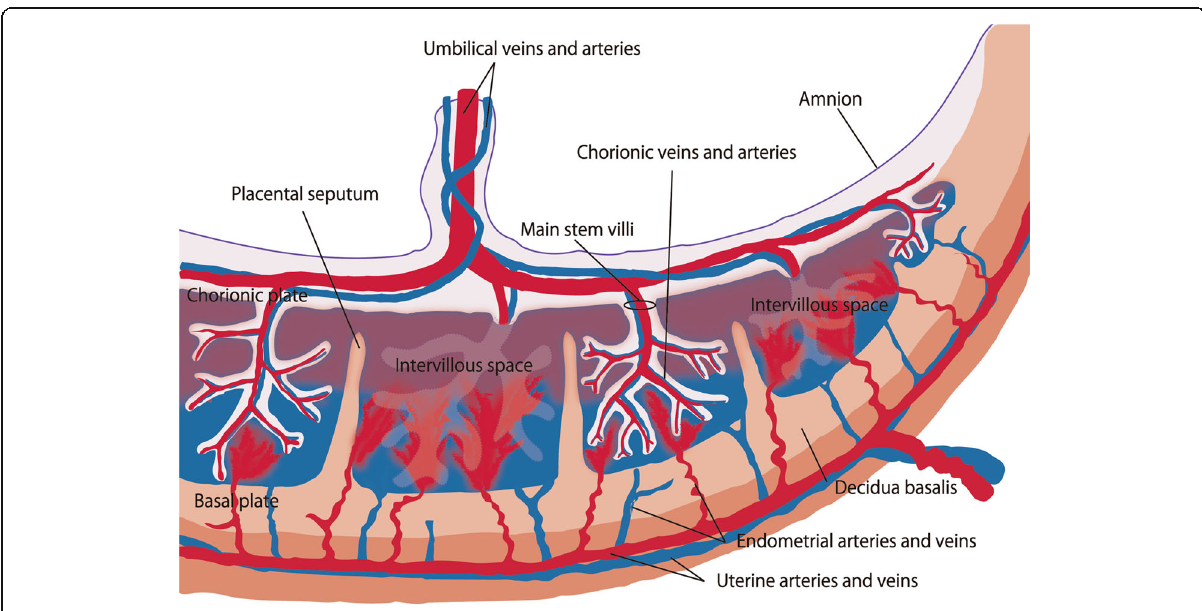
Fig. 3 Schematic drawing of the placenta (cross-sectional image). The chorionic plate (fetal side) is a mass of connective tissue that contains the amnion, main stem villi, and chorionic arteries and veins. The basal plate (maternal side) consists of trophoblastic and decidual cells; it contains the placental septa, decidua basalis, and endometrial arteries and veins. The chorionic and basal plates are separated by the intervillous space;